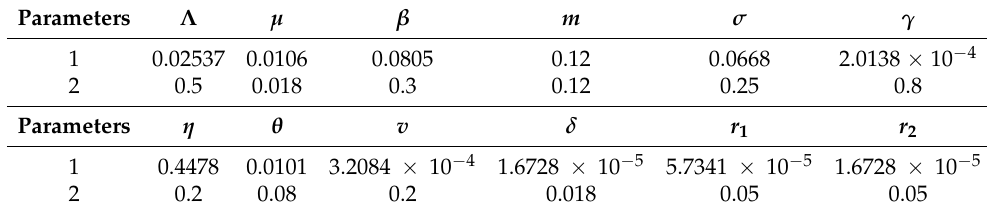
Figure 2. Local asymptotic stability of the disease-free equilibrium point when τ is different. Table 1. System parameter values used in the